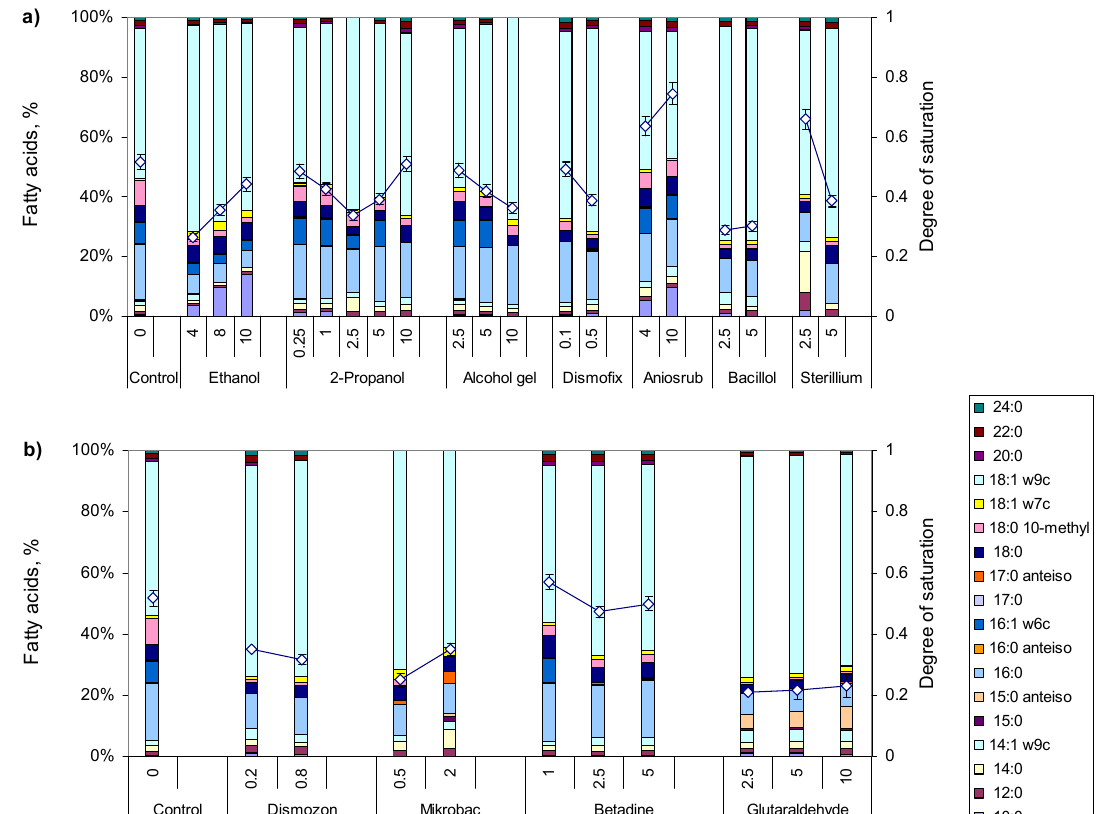
Figure 1. Fatty acid composition, and respective calculated degree of saturation, of M. vaccae cells grown in the absence (Control in both a and b) and in the presence of either alcohol ( a ) or non-alcohol ( b ) based disinfectants. Only FA accounting for at least 1% of total lipids are represented. The content of each fatty acid presented here may be found in Table S1.